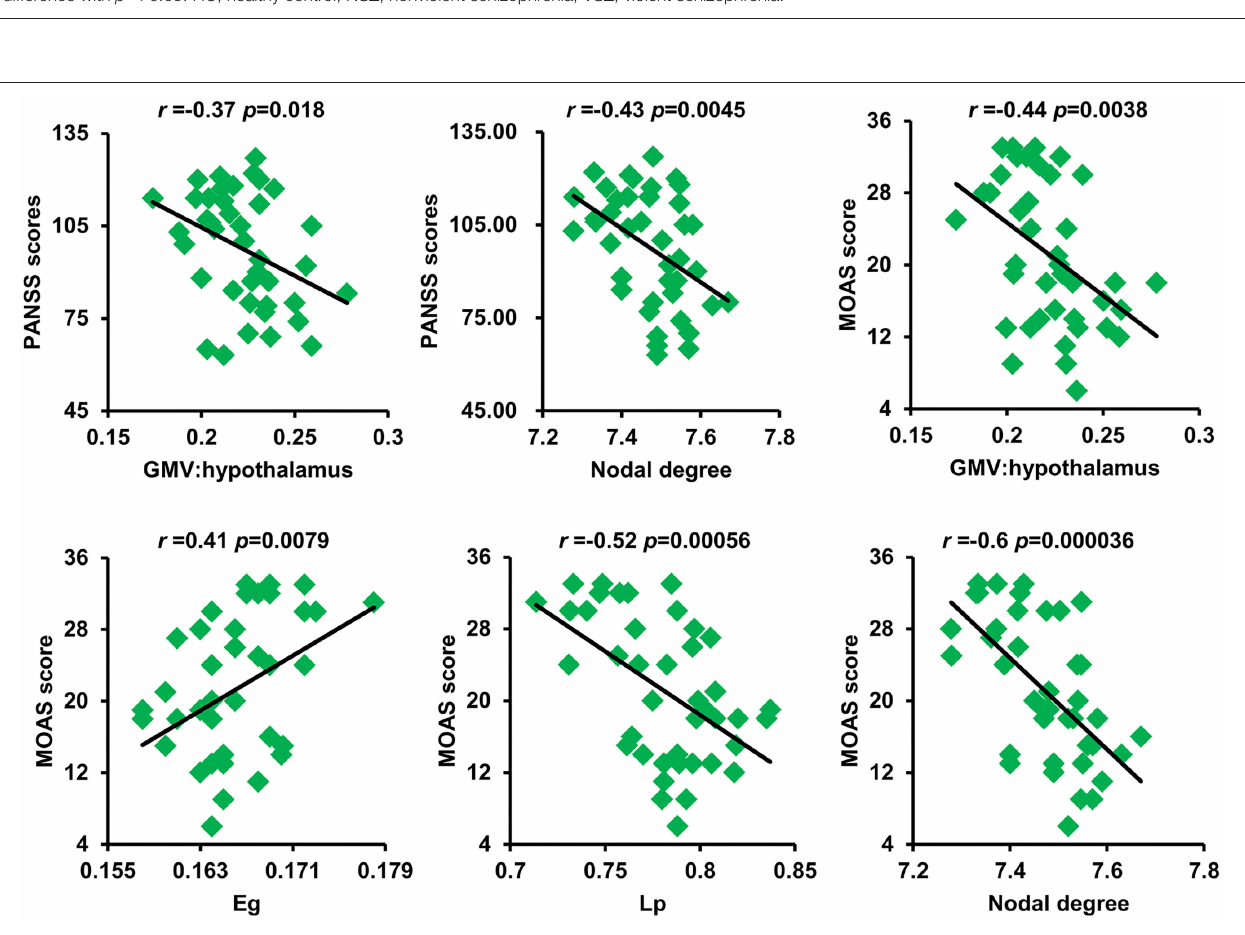
FIGURE 3 | Significant differences in global efficiency (Eg), shortest path length (Lp), and nodal degree were found among the HC, NSZ, and VSZ groups. A gradient increase in Eg and a gradient decrease in Lp from HCs to NSZ and VSZ were found. NSZ had a significantly higher nodal degree than both HCs and VSZ. * Significant difference with p < 0.05. HC, healthy control; NSZ, nonviolent schizophrenia; VSZ, violent schizophrenia.